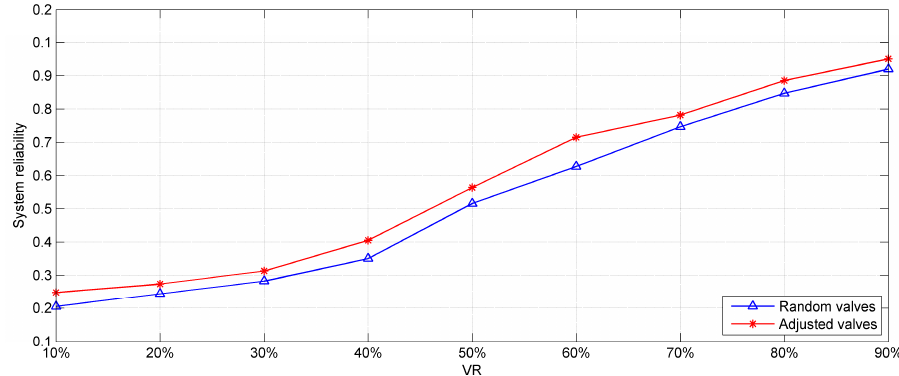
Figure 6. System reliability of the valve adjustment scheme and the random located scheme.